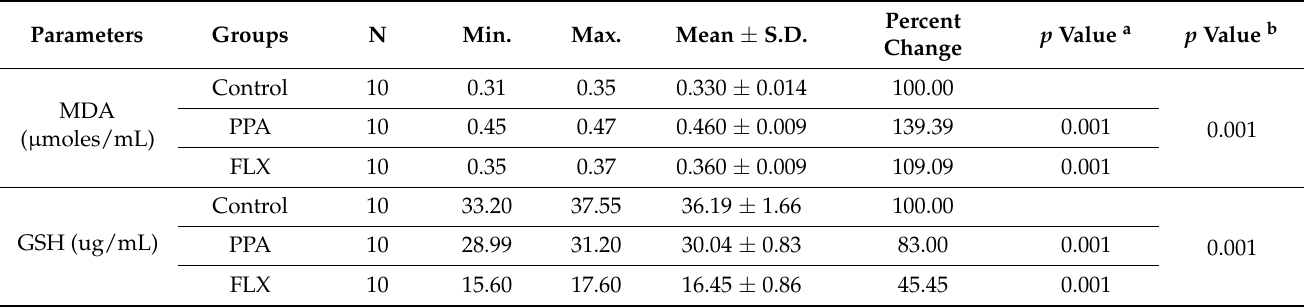
Table 1. Mean ± SD of all the measured parameters in brain homogenate of all treated groups compared with the